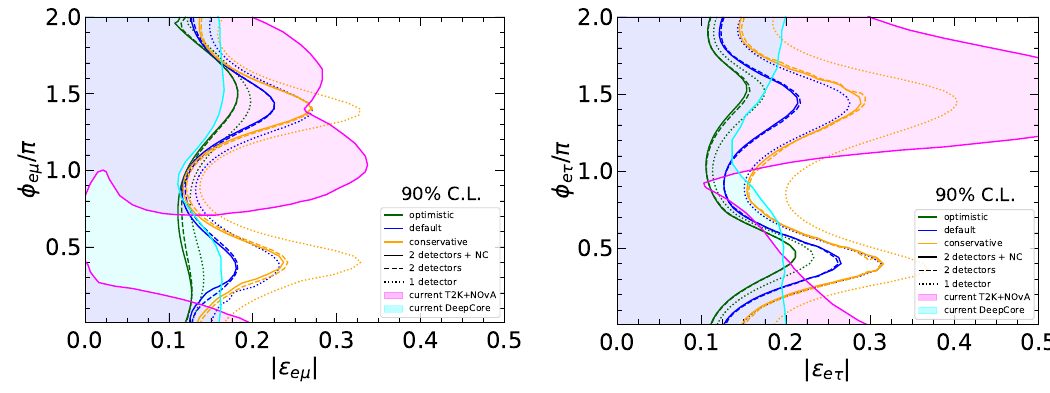
Figure 2 . The expected exclusion region in the (cid:15) eµ - δ eµ and (cid:15) eτ - δ eτ planes at 90% C.L. for different choices of systematic uncertainties. Also shown are the allowed region extracted from ref. [30] and the bounds from ref.